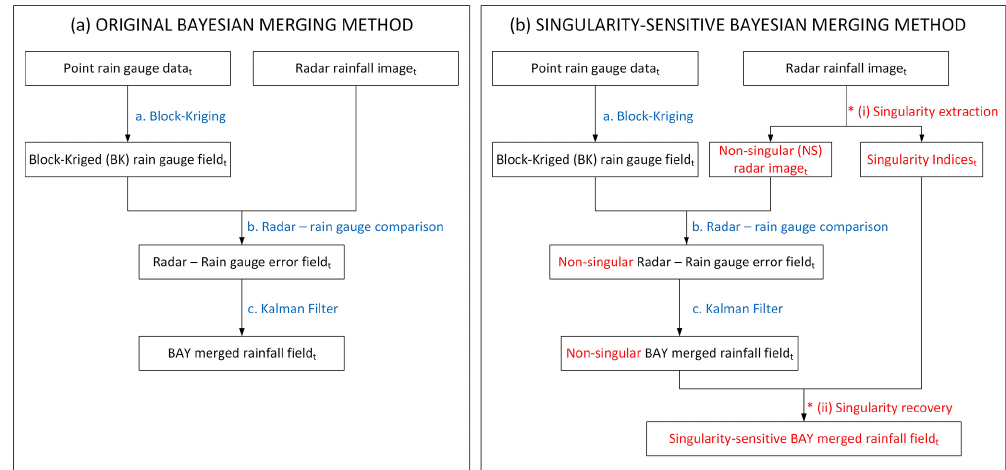
Figure 1. Schematics of (a) original Bayesian merging method (adapted from Fig. 2 in Mazzetti (2012)) and (b) singularity-sensitive Bayesian merging